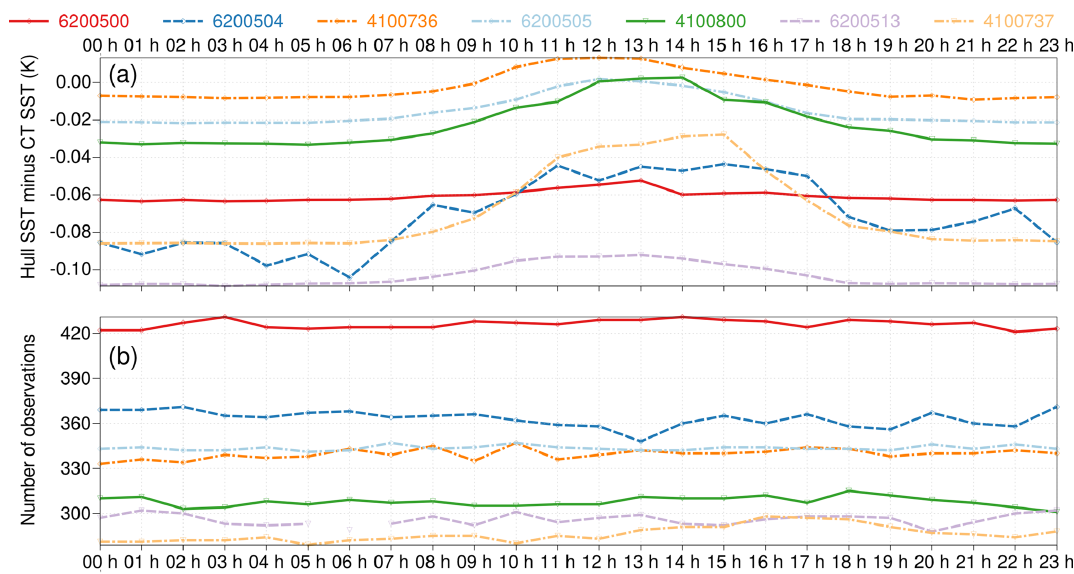
Figure 3. Mean differences (a) between the two SST sensors, with the number of data records shown in panel (b) , for HRSST-2 SVP-BS buoys that reported for at least 250 days (WMO identifier indicated in legend), as a function of mean solar local time (horizontal